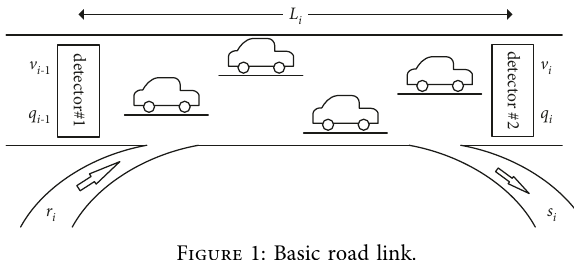
Figure 1: Basic road link.